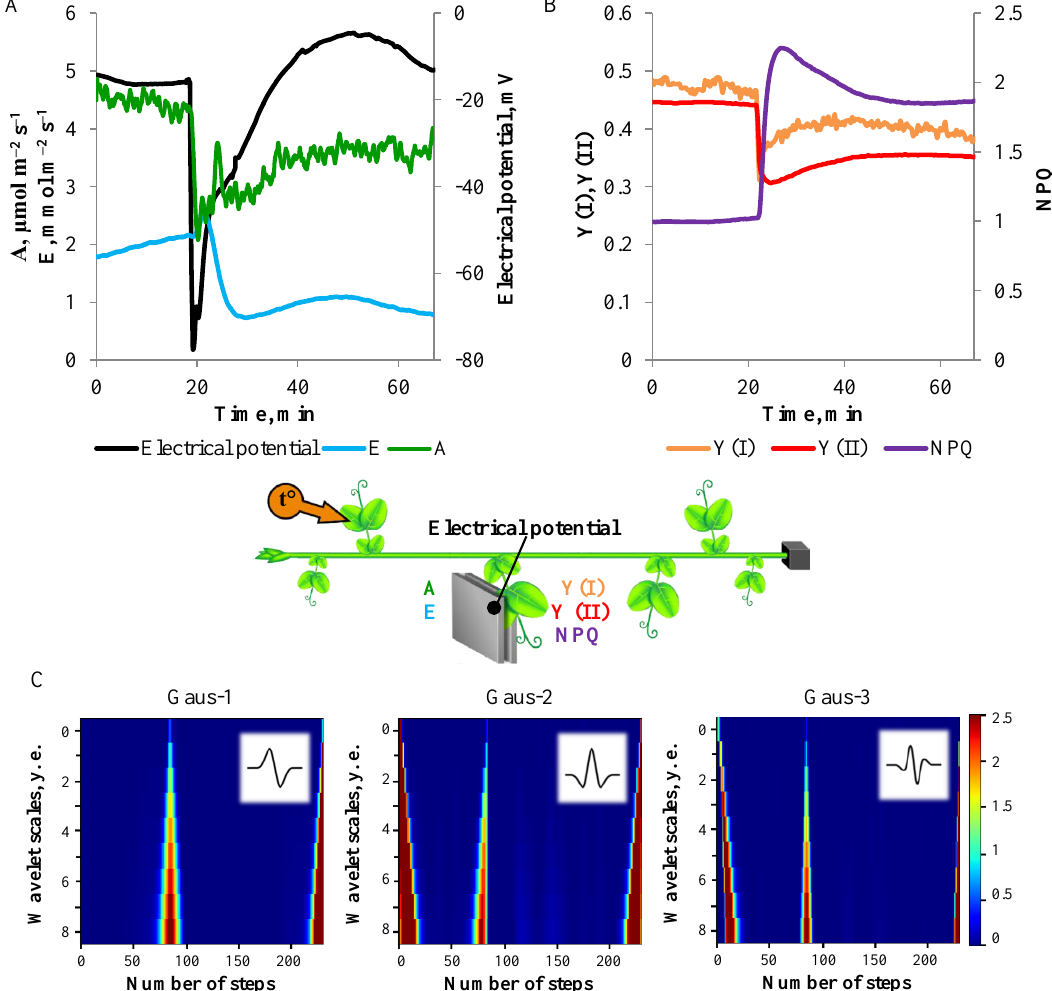
Figure 5. The typical record of VP-induced changes in ( A ) rate of CO 2 assimilation (A, µ mol s − 1 m − 2 ) and level of transpiration (E, mmol s − 1 m − 2 ); ( B ) parameters of photosynthesis (NPQ, Y (I), Y (II)). The decrease in Y (I), Y (II), A and the increase in NPQ indicate a suppression of photosynthesis. The scheme of the experiment is shown: VP was induced by heating of the top leaf of pea seedling; the measurements were performed on an un-wounded leaf. ( C ) Scalograms of Y (II) dynamics wavelet transformation by means of first- to third-order Gaussian basses. One step is equal to 20 s. The reaction started at 23 min, that is expressed as a local maximum on a scalogram. NPQ: non-photochemical quenching; VP: variation potential.